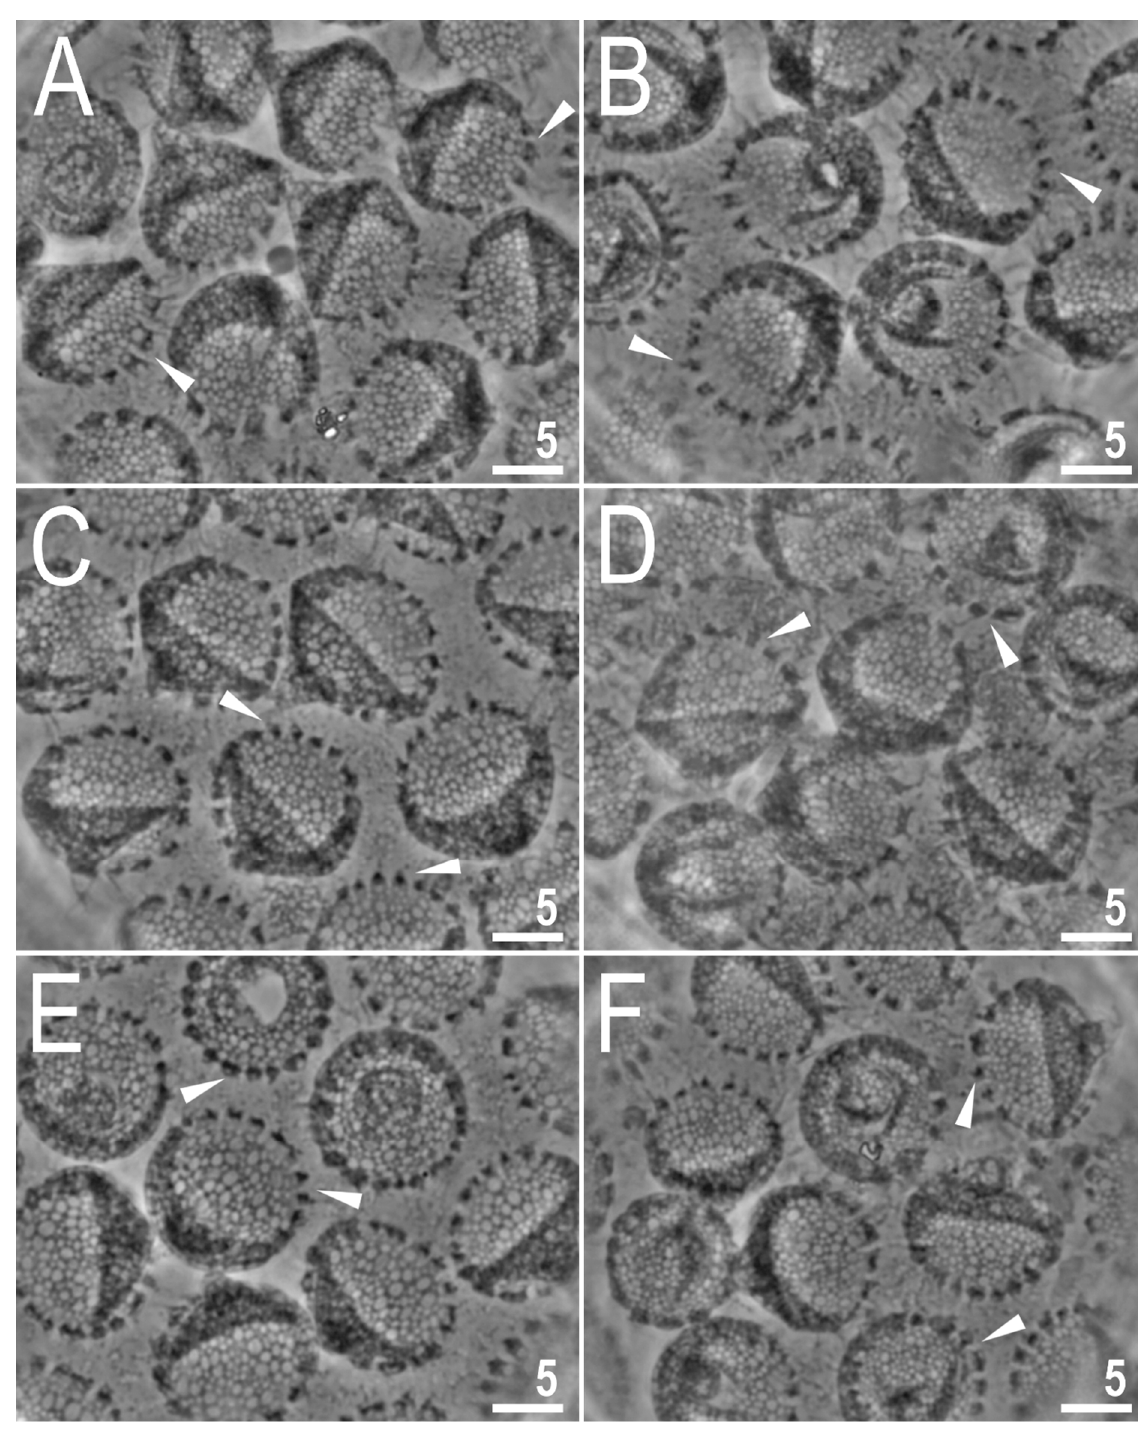
Figure 4. Mesobiotus imperialis sp. nov. —PCM images of the egg surface under ×1000 magnification. Arrowheads indicate crowns of strong thickenings around the process bases. Scale bars in μ m.